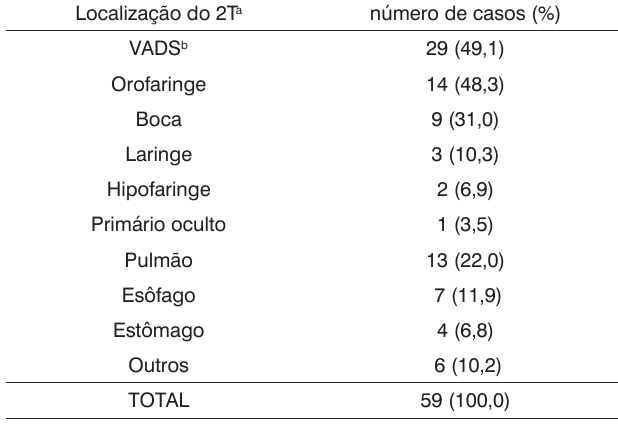
Legenda: a 2T: segundo tumor primário b VADS: vias aerodigestivas